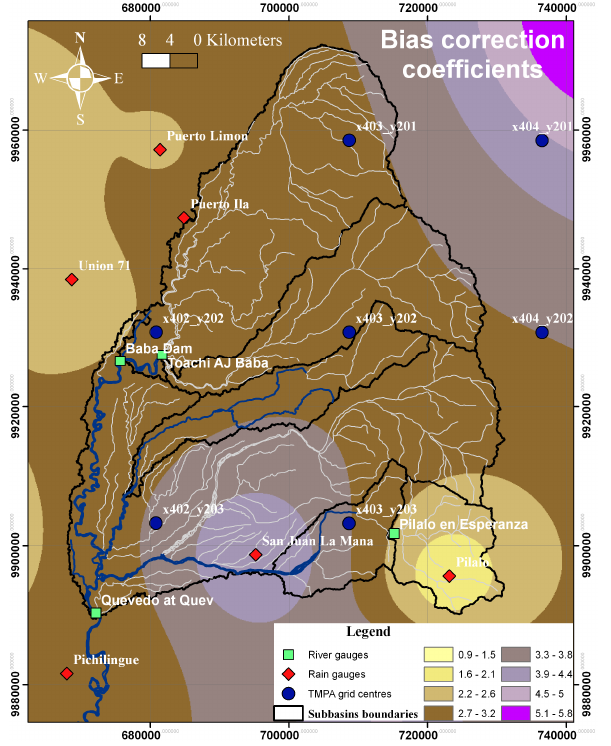
Fig. 5. Spatial distribution of bias corrector coefficients at monthly scale. Vinces upper catchment.